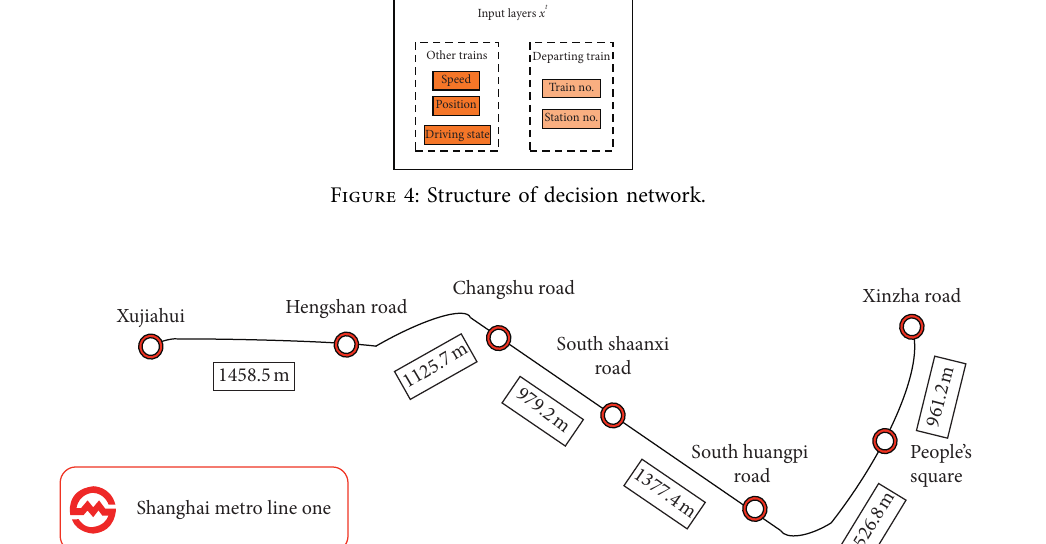
Figure 5: Information of the pilot metro system.